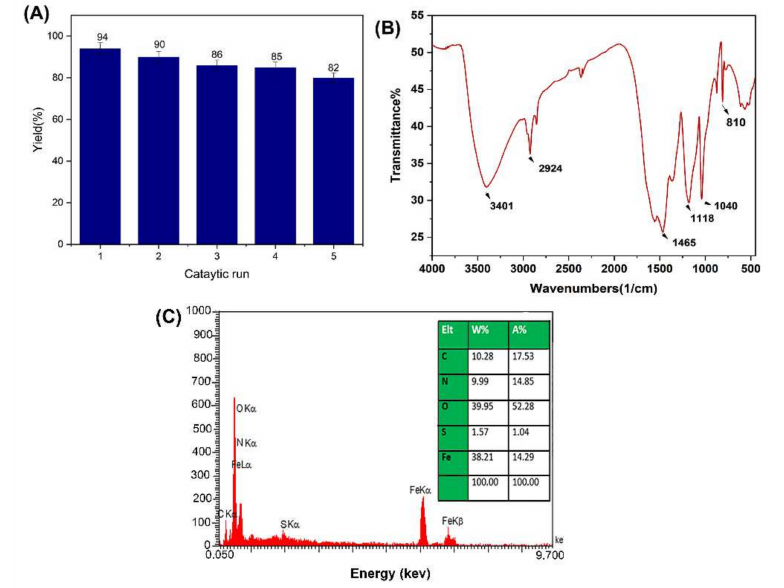
Figure 8. Reuse of MSMF in the synthesis of benzyl pyrazolyl naphthoquinones ( A ), as well as FTIR ( B ) and EDX ( C ) spectra of the recovered MSMF